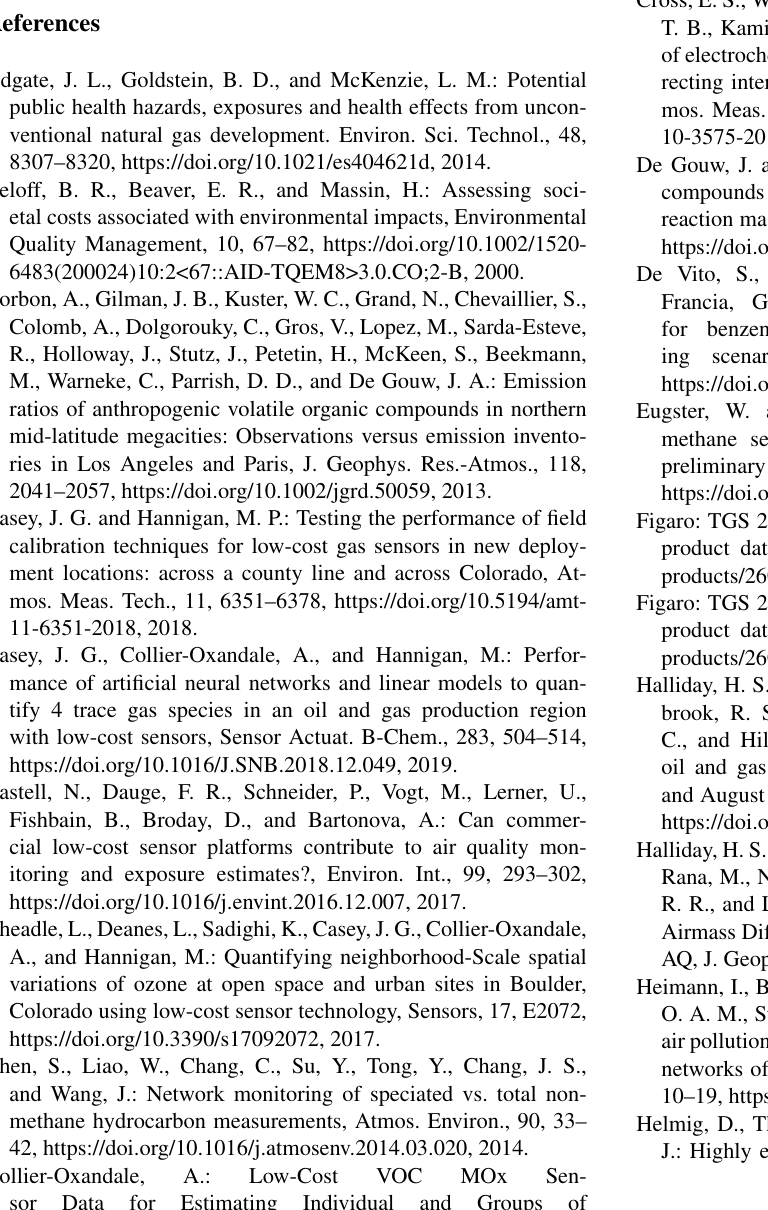
Figaro: TGS 2600 – for the detection of air contaminants, On-line product data sheet, available at: http://www.figarosensor.com/ products/2600pdf.pdf (last access: 4 October 2017), 2005a. Figaro: TGS 2602 – for the detection of air contaminants, On-line product data sheet, available at: http://www.figarosensor.com/ products/2602pdf.pdf (last access: April 2018),